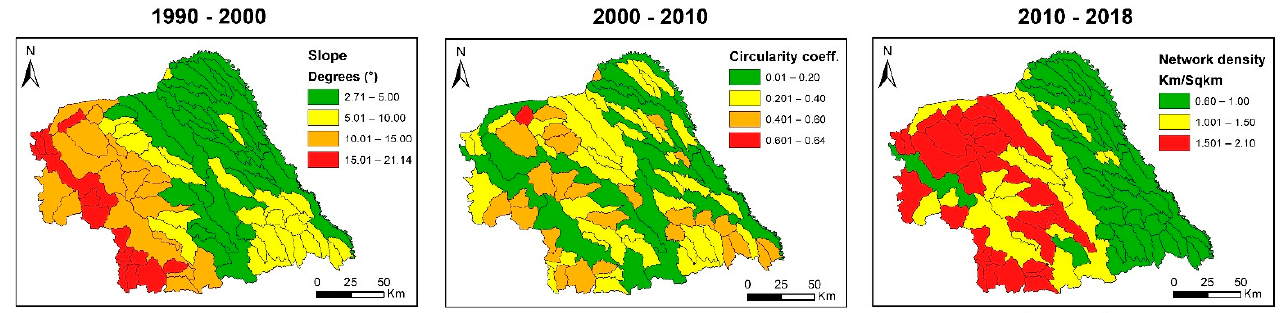
Figure 6. An overview of the constant factor values in the study area.